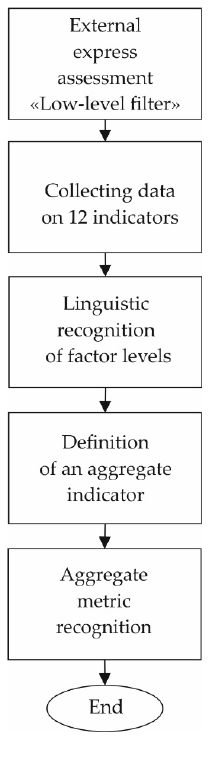
Figure 2. Resilience express assessment method.